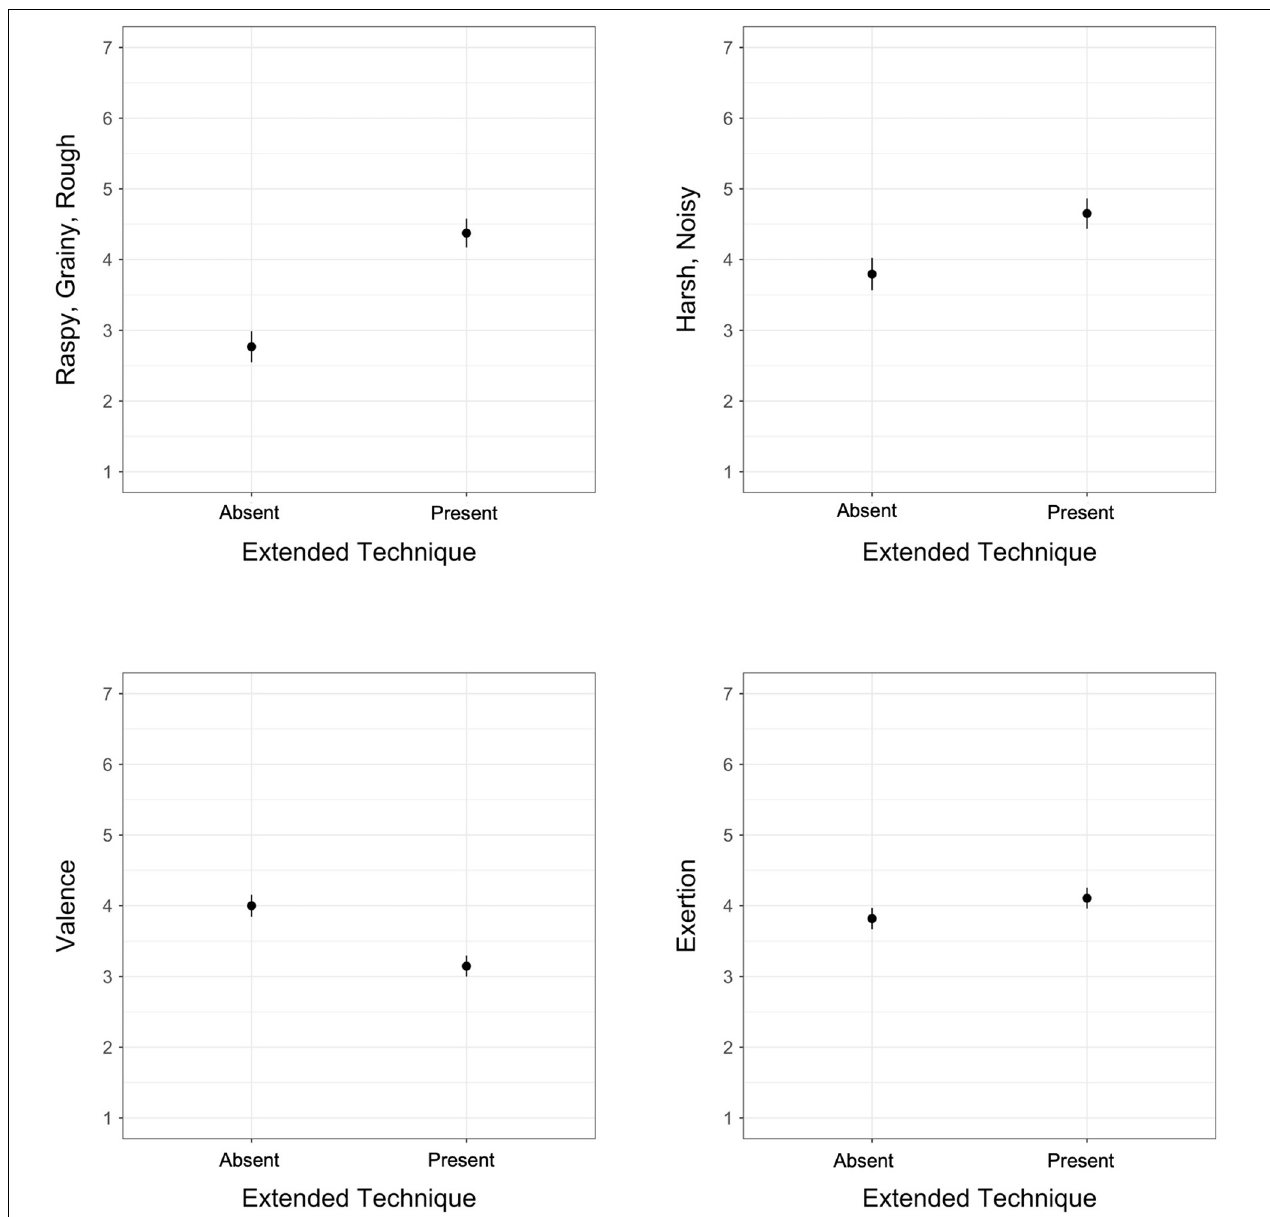
FIGURE 1 | Estimated marginal means for the absence/presence of an extended technique in models of exertion, valence, raspy/grainy/rough , and harsh/noisy ; vertical bars represent 95% confidence